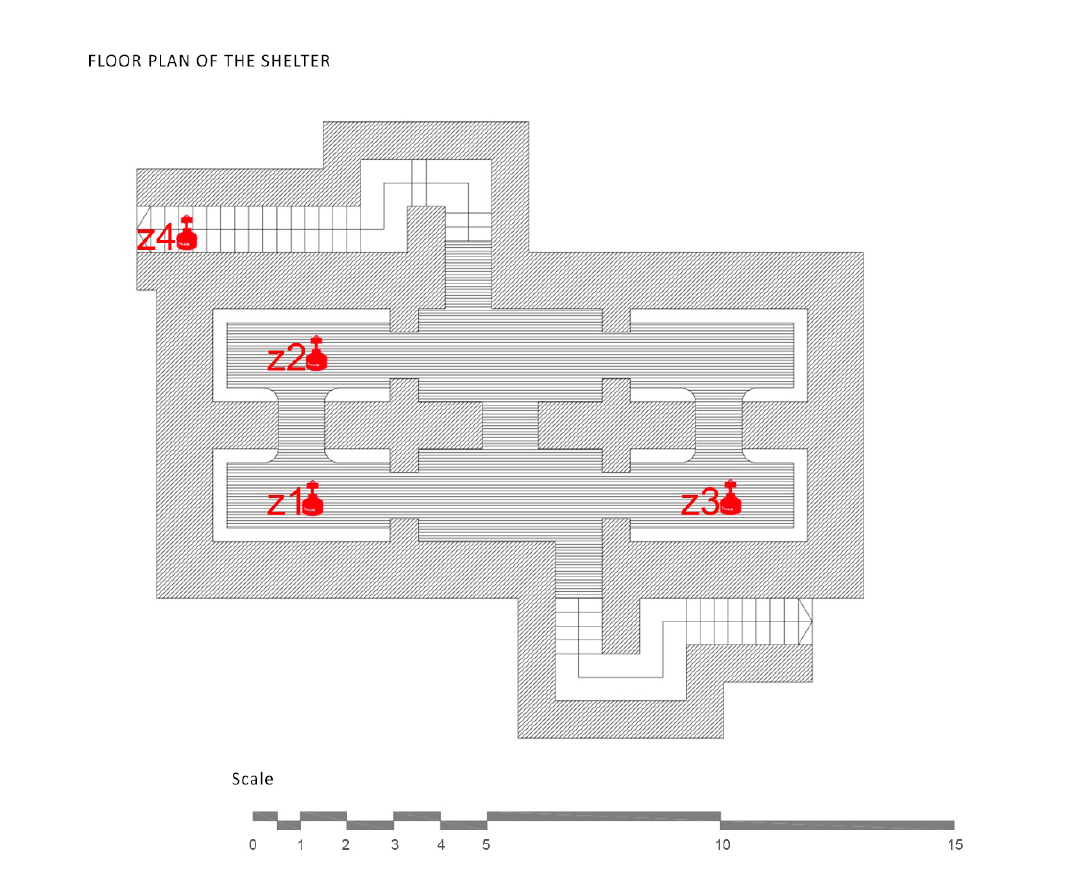
Figure 11. Measurement areas made inside the Plaza Balmis